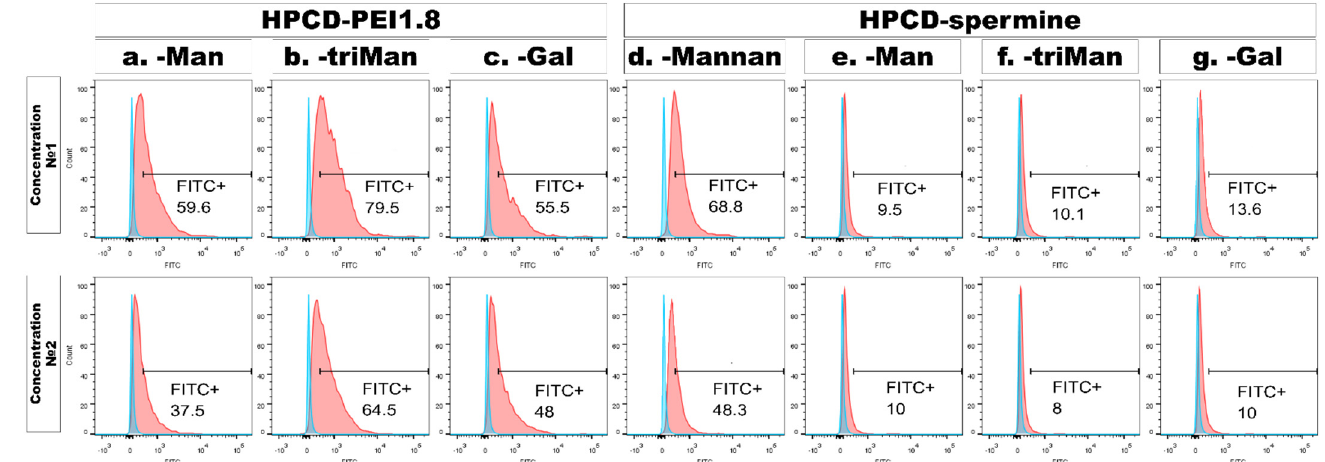
Figure 7. Flow cytometry results of macrophages incubated with polymer samples. Two types of polymers: HPCD-PEI1.8 and HPCD-spermine, modified with mannose ( a , e ), trimannose ( b , f ) or galactose ( c , g ) and one sample modified with mannan ( d ). Top row—concentration No. 1, bottom row—concentration No. 2 (two times less). Data are presented by overlaid histograms of control macrophages (blue) and macrophages after incubation with sample (red) represented by histograms. The percentage of cells in the gate is indicated under the name of the gate.